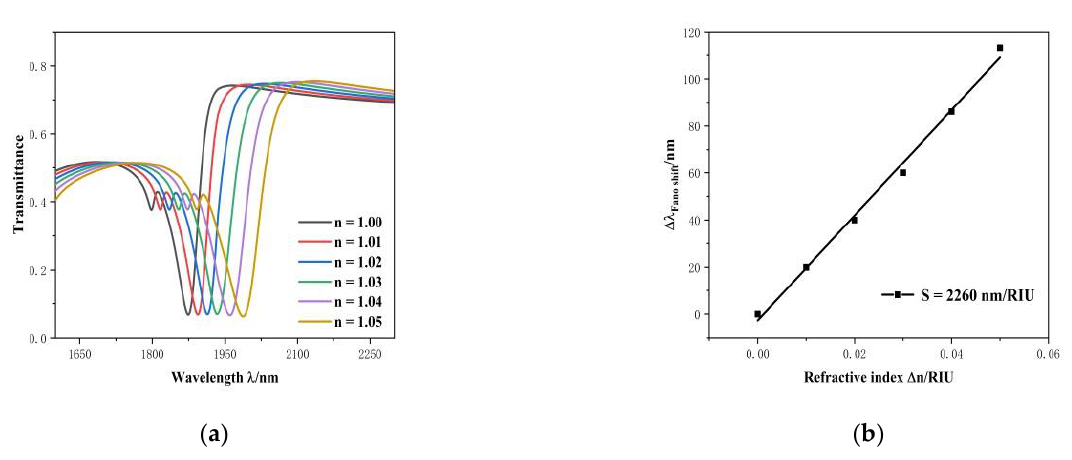
Figure 4. ( a ) Transmission spectrum of the whole system for various refractive indexes; ( b ) variation of the dip point’s wavelength in Fano resonance ( Δλ ) with a changed refractive-index ( Δn ).